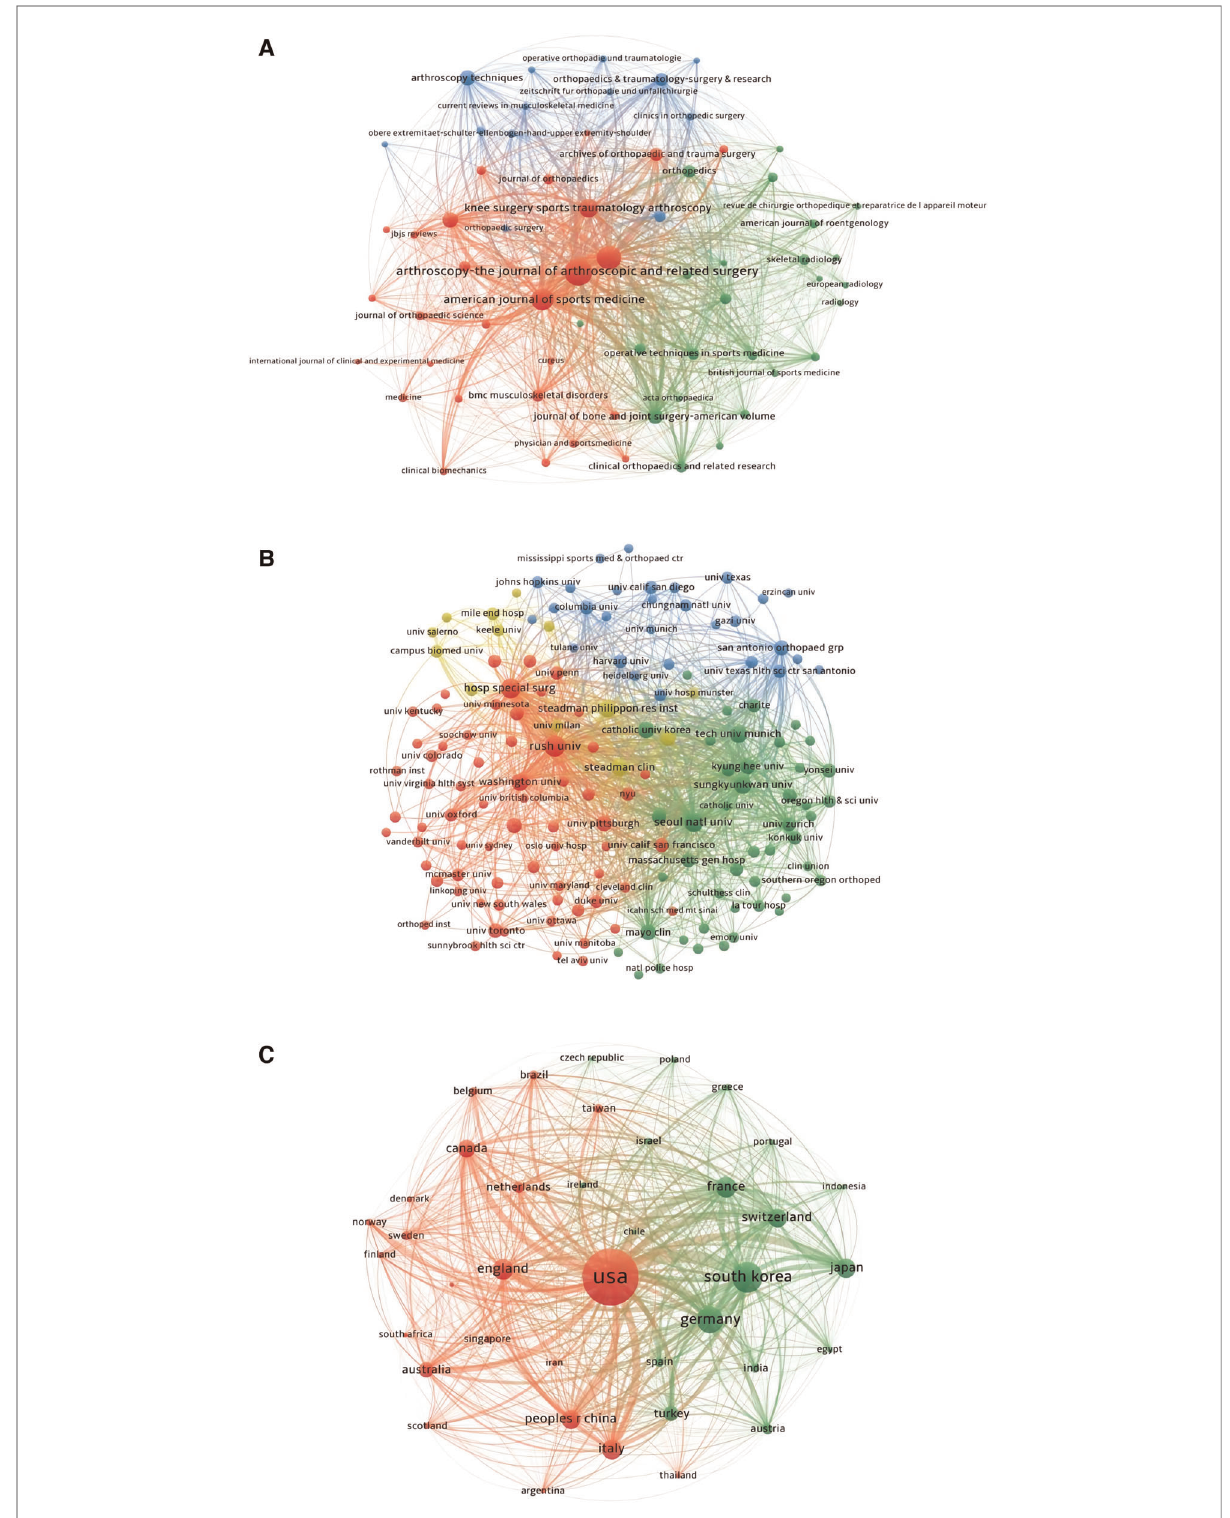
FIGURE 8 Bibliographic coupling analysis of journals, institutions, and countries (analysis based on the arthroscopic therapy of rotator cuff diseases related publications from 2002 to 2021). ( A ) Mapping of the 64 identi fi ed most relevant journals. ( B ) Mapping of the 153 identi fi ed most relevant institutions. ( C ) Mapping of the 69 identi fi ed most relevant